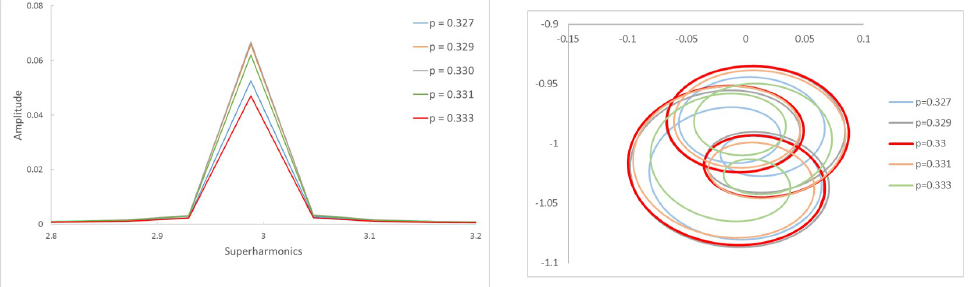
Figure 12. FFT of the transversal displacement and orbits for α = 0.2 and a speed interval close to p = 1 . 3